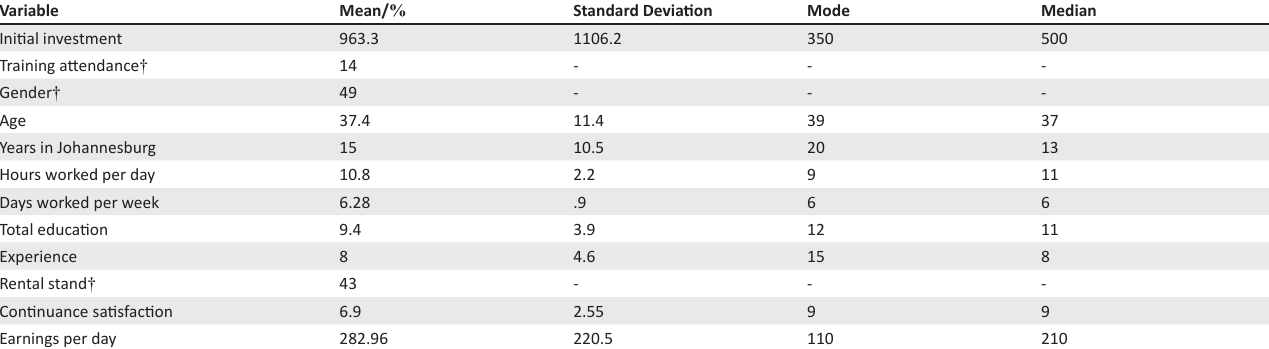
n = 125. † , Binary variables are represented as a percentage.